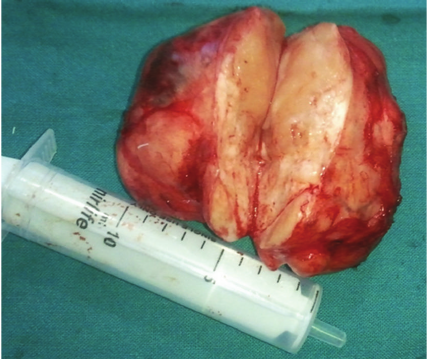
Figure 5: Excised tumor specimen with cut